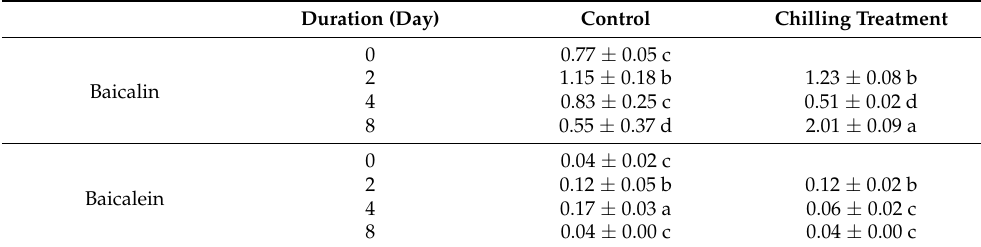
Table 2. HPLC analysis of flavones in shoots of S. baicalensis plantlets after chilling treatment. Duration